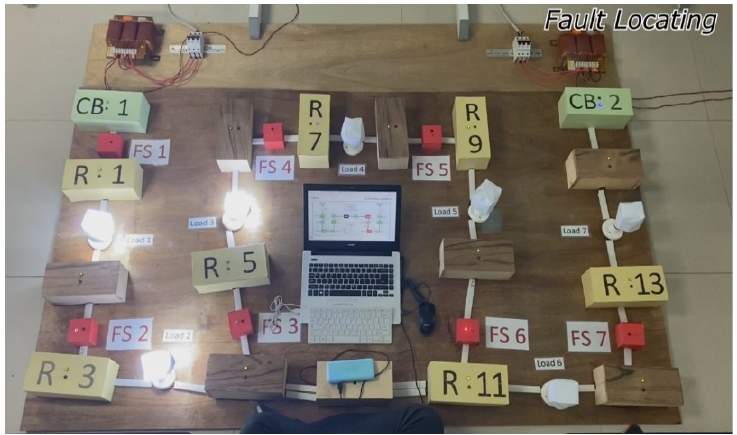
Figure 13. Hardware situation when the fault on Line 11 (FS6) is triggered.